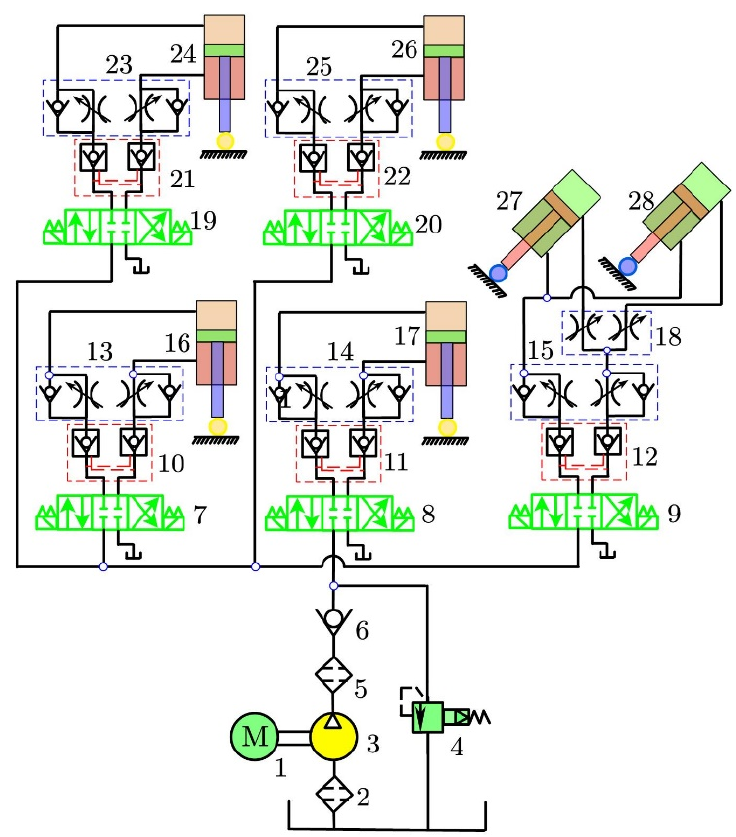
Figure 3. Hydraulic system of traditional gangue conveyor equipment. 1. Electric motor. 2. Filter.